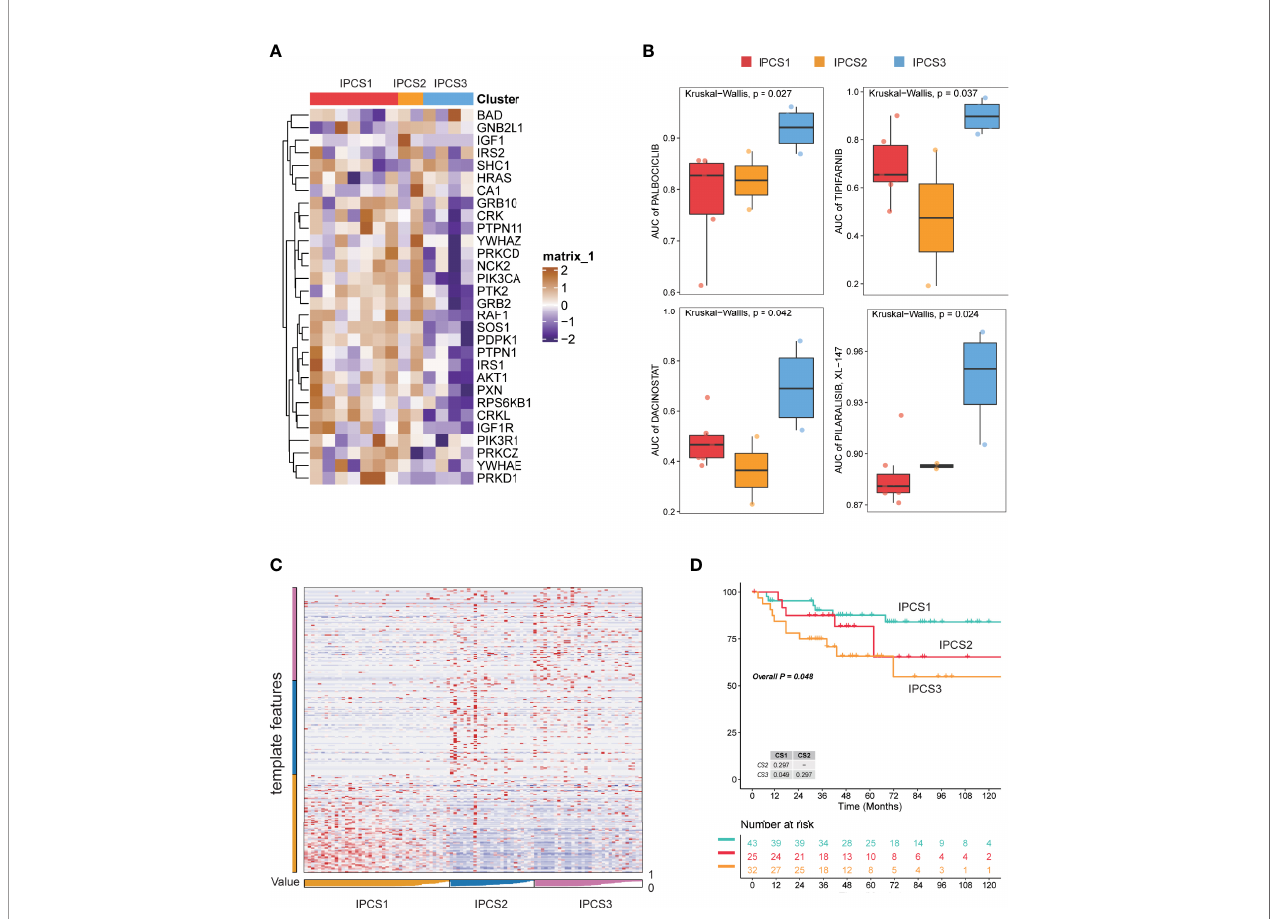
FIGURE 9 | Veri fi cation of subtyping model in external dataset. (A) Heatmap of the expression pro fi les of IGF regulator – related genes among the three subtypes of GDSC renal cancer cells. (B) Drug sensitivity analysis in the form of normalized AUC using GDSC renal cancer cell database. (C) Heatmap of NTP in JAPAN-KIRC cohort using subtype-speci fi c altered biomarkers identi fi ed from TCGA-ccRCC cohort. (D) Survival analysis of the three predicted subtypes of ccRCC in JAPAN- KIRC